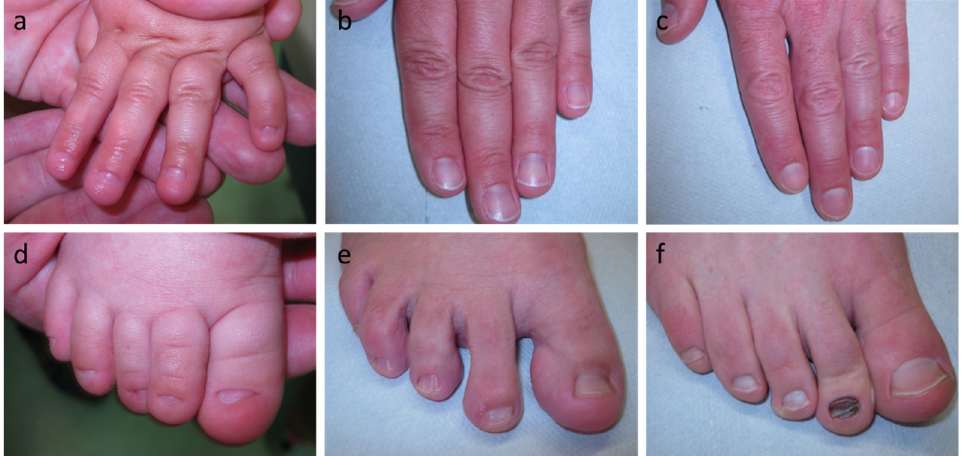
Figure 2. Phenotypic findings in the case of anonychia congenita ( a – c ) Fingernails of the index patient, her mother and her father; ( d – f ) Toenails of the index patient, her mother and her father. While the variant RSPO4 c.296T>C is novel and predicted to be disease-causing, a report on RSPO4 c.273_275delTGG has already been included in the Exome Aggregation